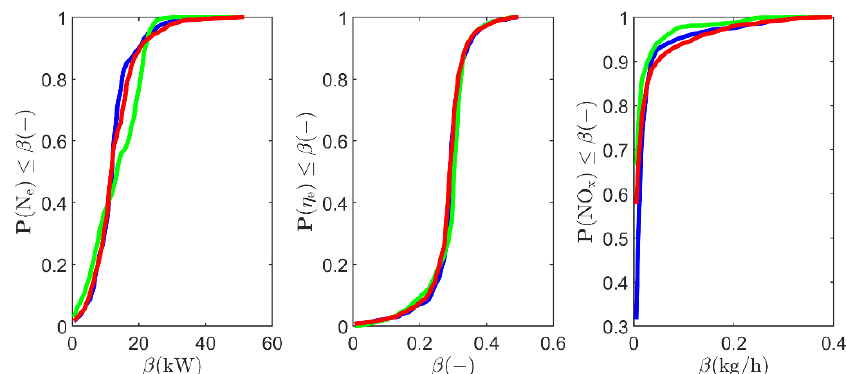
Figure 12. Distribution of engine effective power ( left ), efficiency ( center ) and NOx emissions ( right ) observed in the fuel-oriented cycle (blue), NOx oriented cycle (green) and natural driving cycles (red).